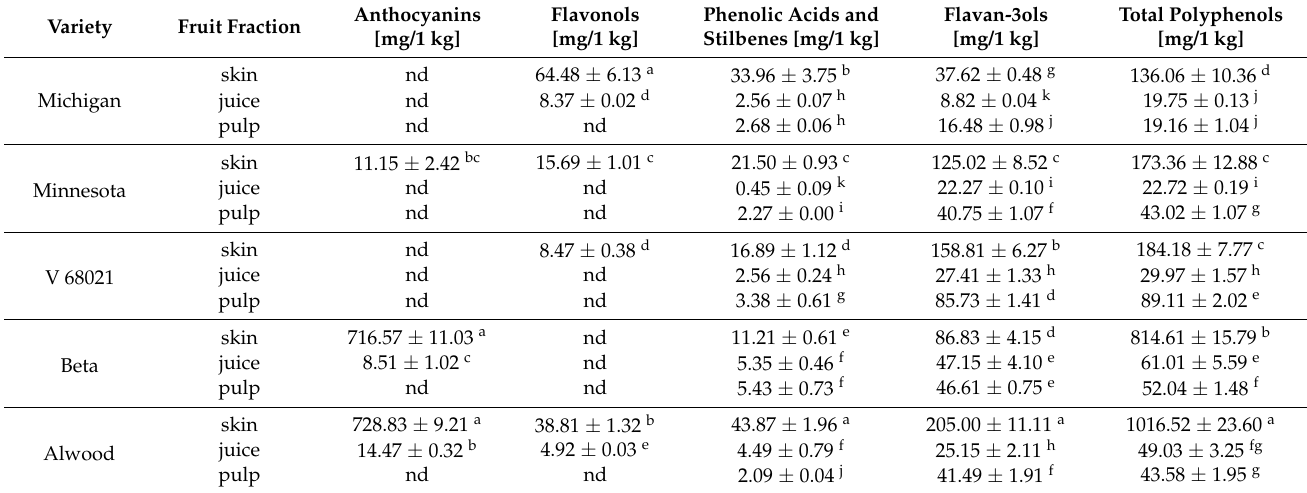
Table 6. The content of polyphenolic compounds in grapevines hybrids skin, juice and pulp. Anthocyanins [mg/1